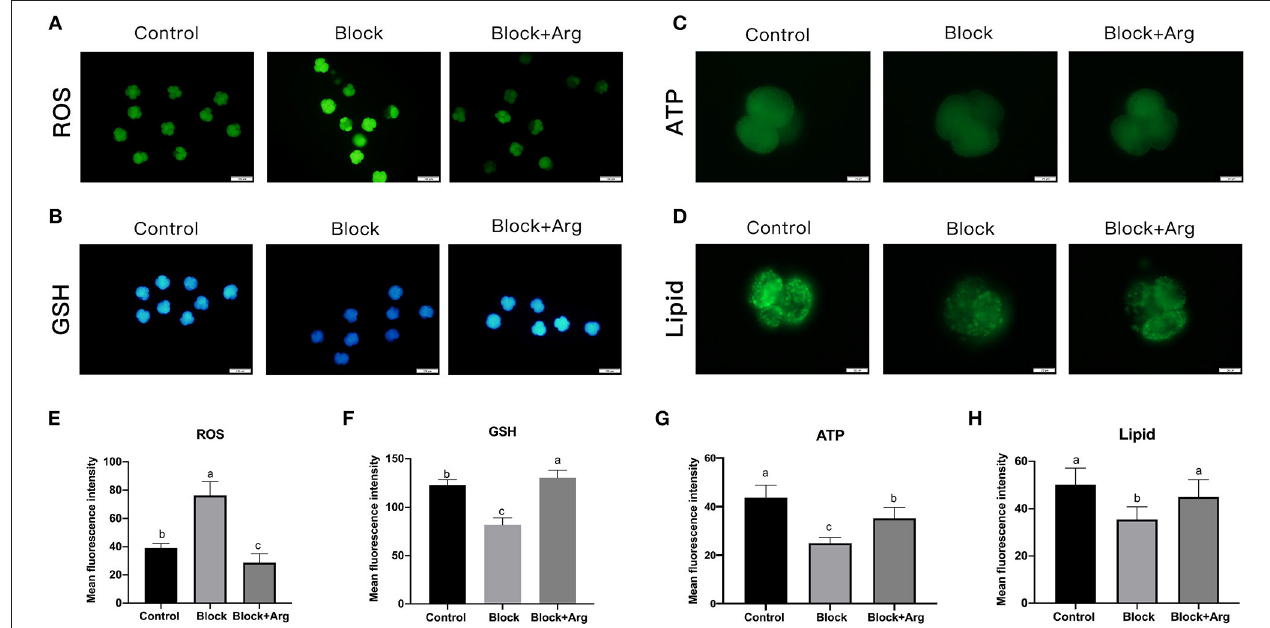
FIGURE 4 | Effects of arginine on the metabolism status of embryos during ZGA under nutrition restriction. (A) The 4-cell embryos were stained with DCFH-DA to measure the intracellular levels of ROS in the Control, Block and Block + Arg groups. Bar = 100 µ m. (B) The 4-cell embryos were stained with Cell Tracker Blue to measure the intracellular levels of GSH in the Control, Block and Block + Arg groups. Bar = 100 µ m. (C) ATP level of 4-cell embryos stained with BODIPY-ATP in the Control, Block and Block + Arg groups. Bar = 50 µ m. (D) Images of 4-cell embryos obtained by epifluorescence microscopy. Lipid droplets were stained with the lipophilic dye BODIPY 493/503 in the Control, Block and Block + Arg groups. Bar = 50 µ m. (E–H) Results of the statistical analysis of embryonic ROS, GSH, ATP and lipid droplet intensity in the Control, Block and Block + Arg groups. Control: n = 30; Block: n = 30; Block + Arg: n = 30. Different letters denote significant differences ( P <